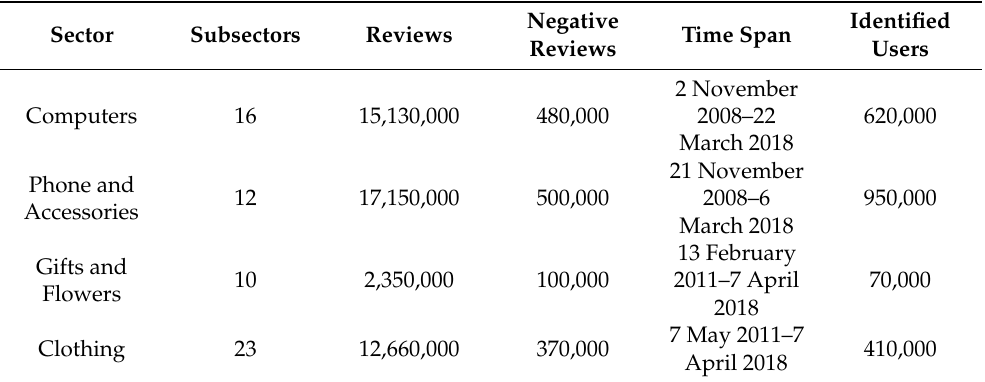
Table 1. An overview of the dataset used in this